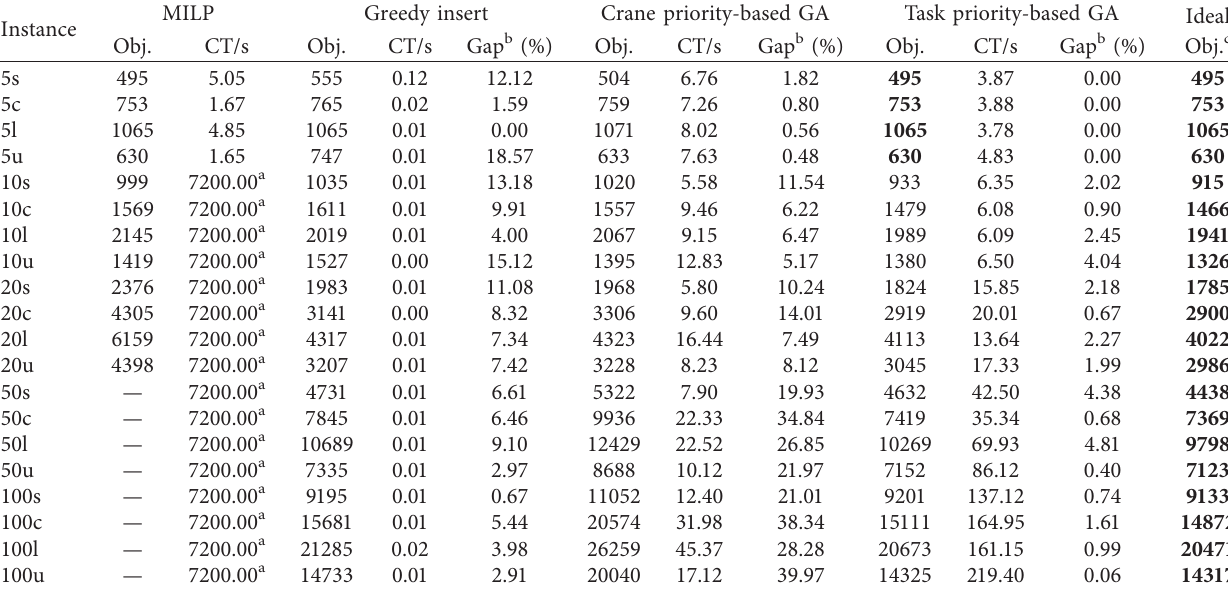
Table 4: Objective value and computation time of solving the model and